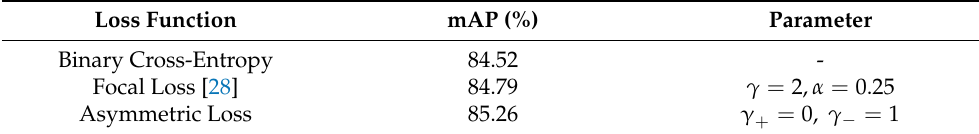
Table 4. Mineral identification results using different loss functions based on the model of the